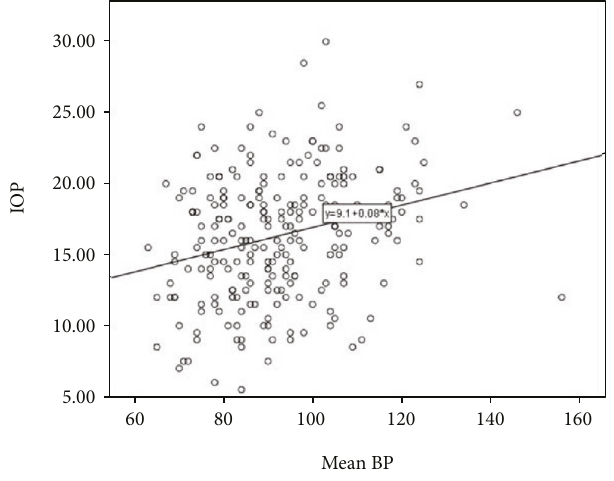
Figure 3: For both fl uid protocols, the linear correlation between IOP and MAP did not di ff er at di ff erent concentrations of fl uid intake (correlation is signi fi cant at the 0.01 level; r = 0 275 ; p value =